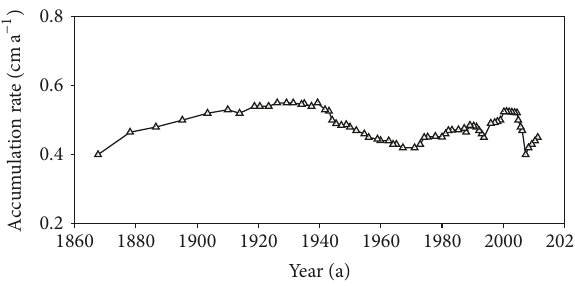
Figure 2: Fluctuation of sediment accumulation rate with time by CRS